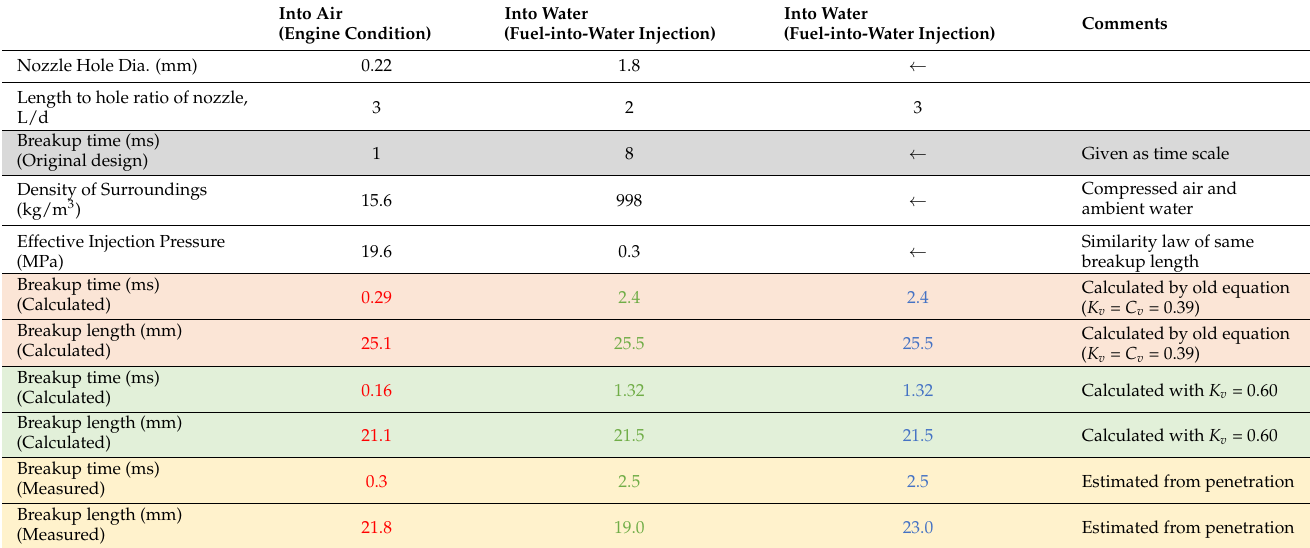
Table 5. Breakup time and breakup length of pseudo sprays.